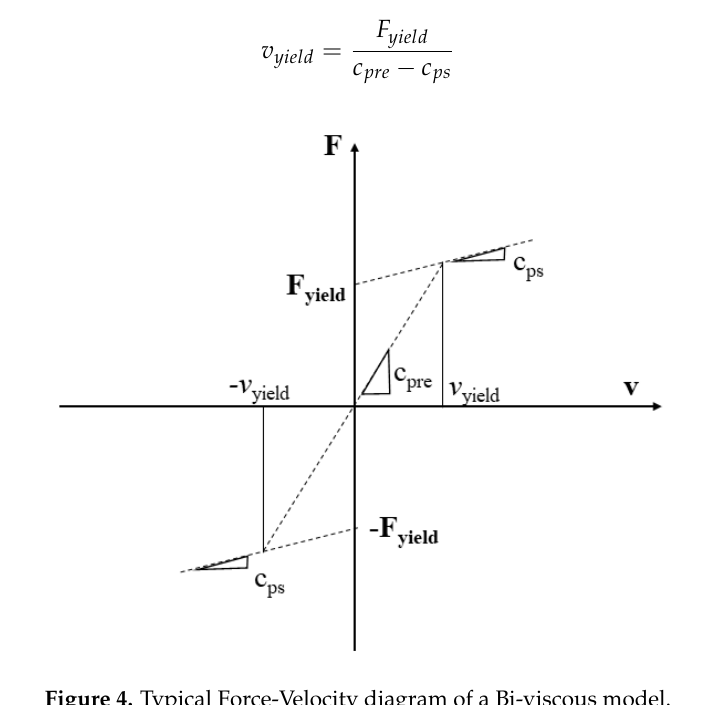
Figure 4. Typical Force-Velocity diagram of a Bi-viscous model.